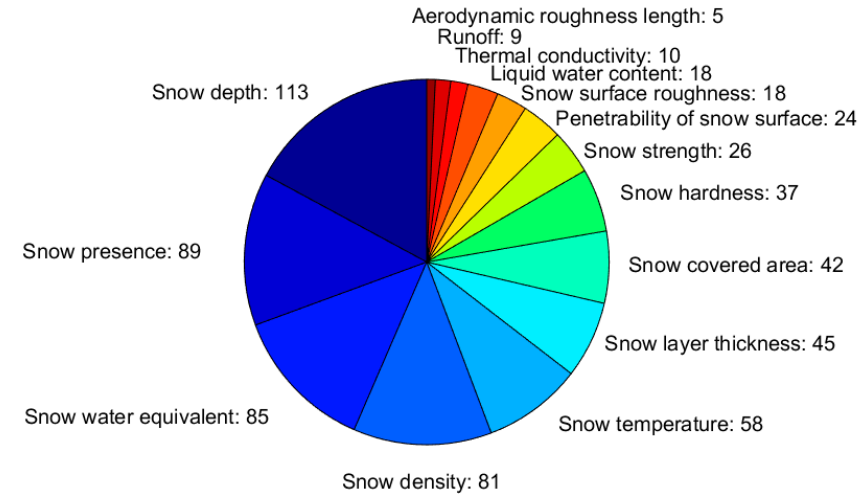
Figure 5. Measured snow macrophysical properties. The width of each slice corresponds to the fraction each macrophysical property has relative to the total number of reported macrophysical properties (i.e., the sum of the numbers given in the figure).